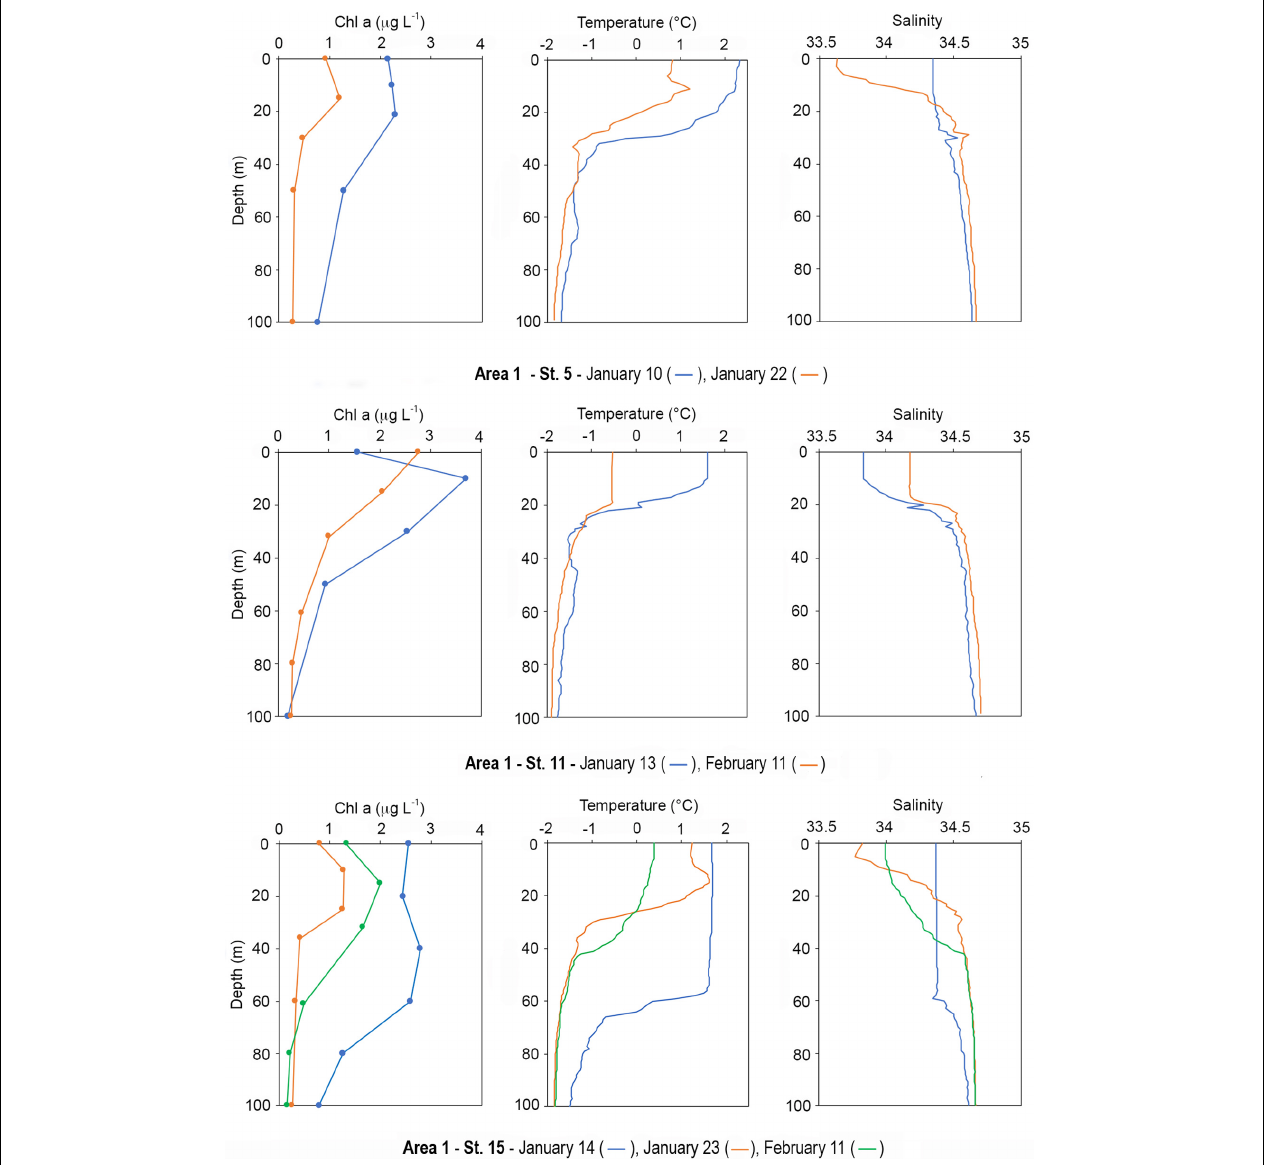
FIGURE 10 | Vertical profiles of chl a ( µ g L − 1 ), temperature, and salinity at resampled stations in Area 1. Stations 5, 11,